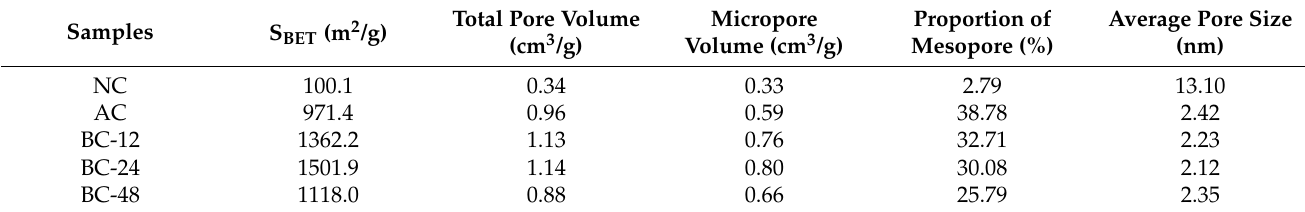
Table 1. Porosity analysis of NC, AC, and BC- x